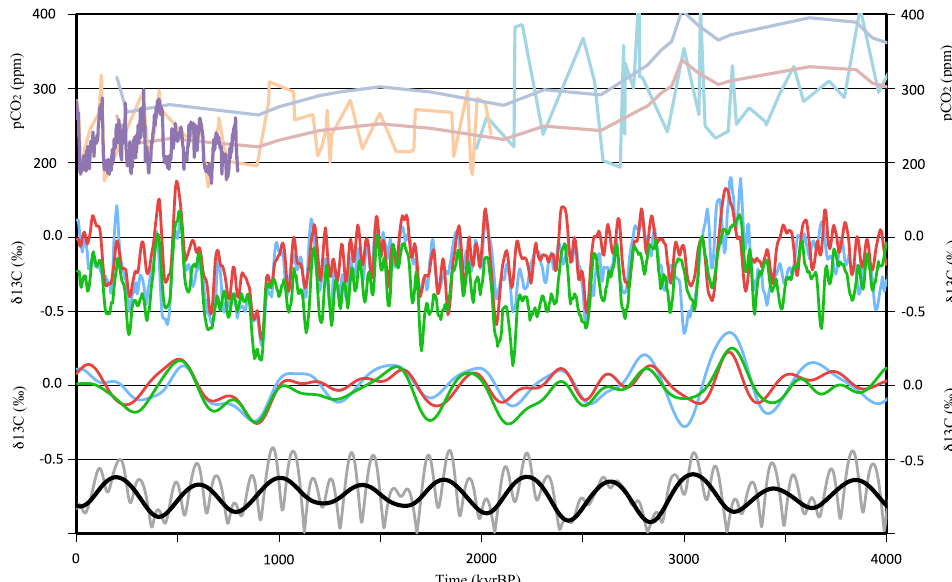
Figure 1. From top to bottom: p CO 2 records from Antarctic ice cores (purple: Lüthi et al., 2008); from boron isotopes in marine cores (orange: Hönisch et al., 2009; light blue: Bartoli et al., 2011) and alkenone isotopes (pink and blue lines for the min and max envelope, from Seki et al., 2010). δ 13 C in cores 1143 (red: Wang et al., 2004); 849 (blue: Mix et al., 1995); 846 (green: Shackleton et al., 1995). The same δ 13 C records filtered at 400kyr (bandpass = 2.5Myr − 1 ), eccentricity (grey, from Laskar et al., 2004) and filtered eccentricity